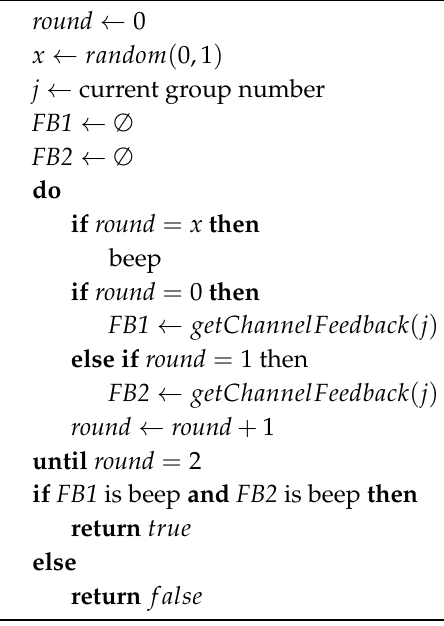
Algorithm 2: C HECK -C OLLISION P